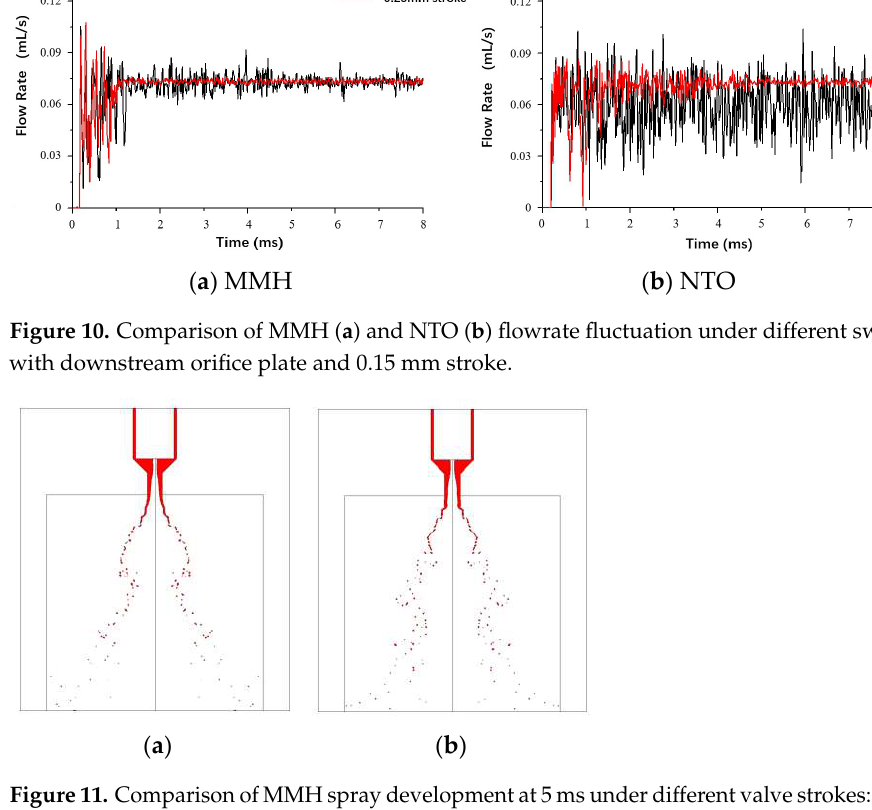
Figure 11. Comparison of MMH spray development at 5 ms under different valve strokes: ( a ) 0.15 mm, ( b ) 0.25 mm, at 0.25 m/s switch speed with downstream orifice plate.